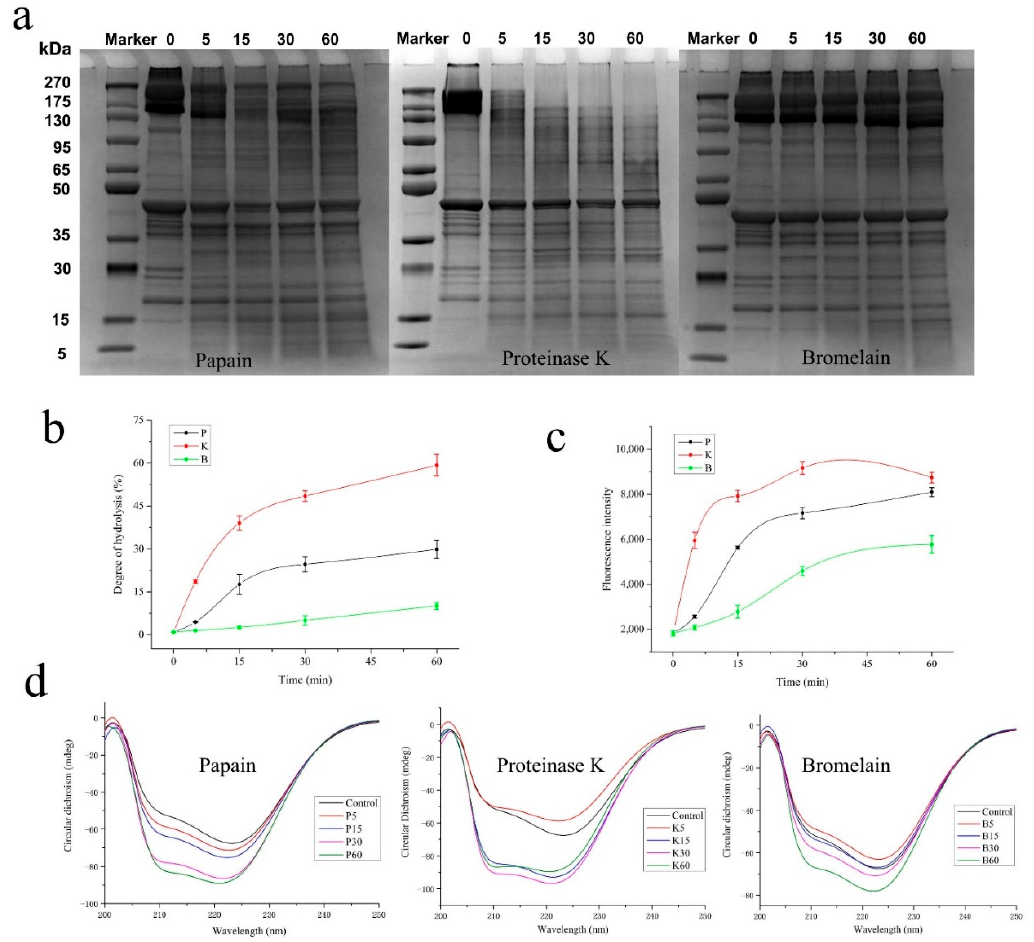
Figure 1. Effect of protease treatments on the changes in SDS-PAGE images ( a ) and DH ( b ), surface hydrophobicity ( c ) and CD spectra ( d ) of MP. DH and surface hydrophobicity measurements were repeated in triplicate.